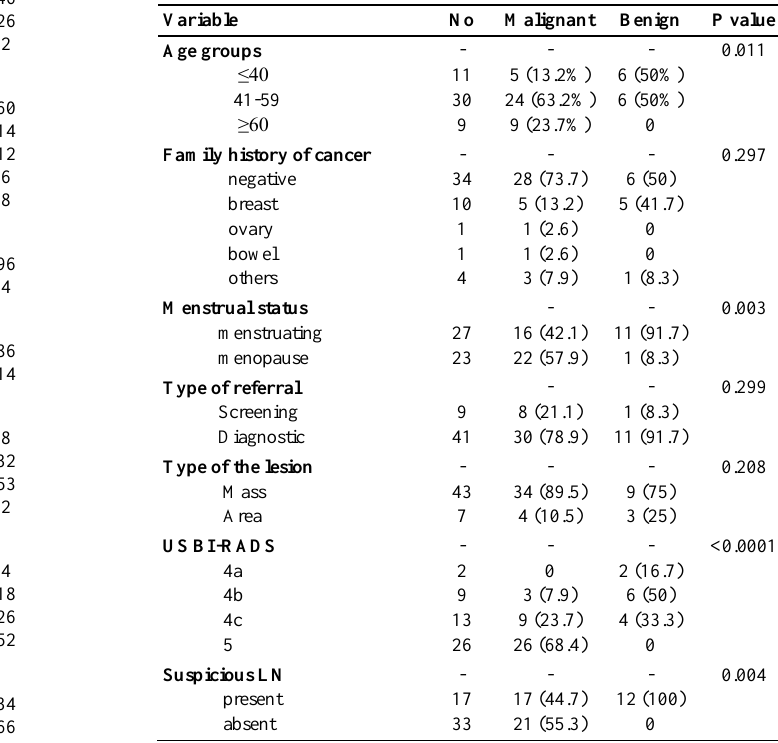
Table 3: Clinical and radiological features of malignant and